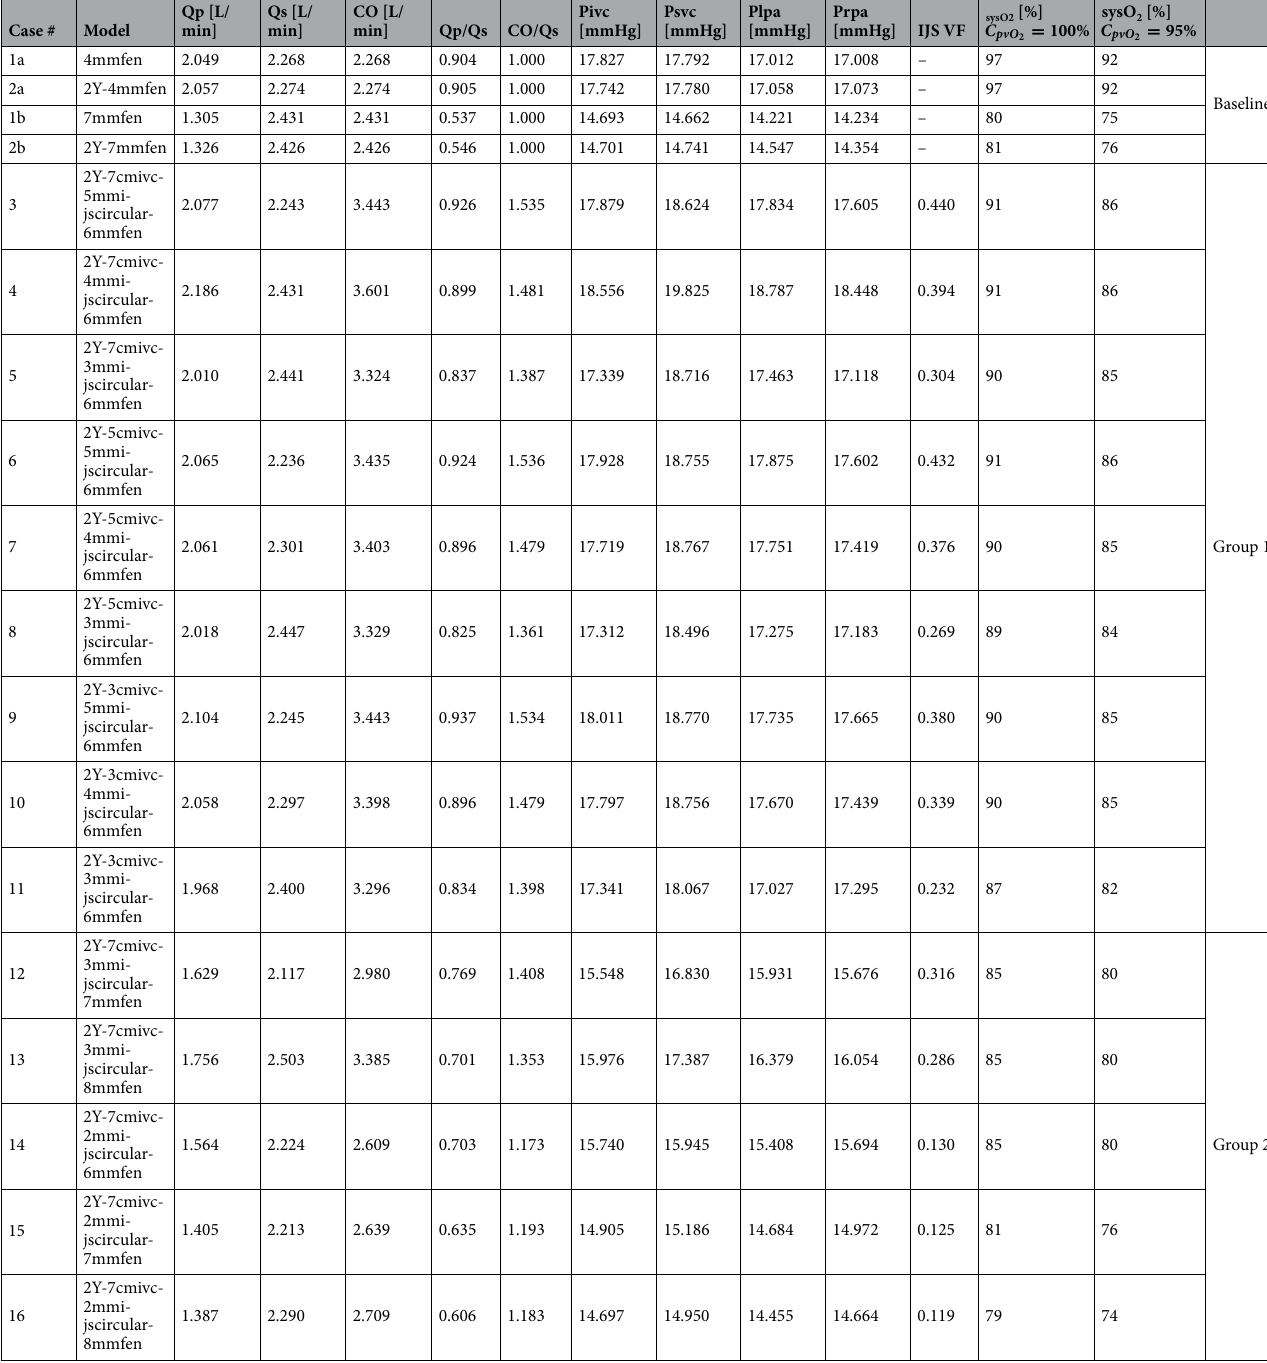
Table 2. Summary table of exploration of IJS and fenestration size and placement, including modified double Y-graft (2Y) anatomic variant (model nomenclature: [anatomic variant] − [distance from IJS nozzle to cavopulmonary connection] − [IJS diameter] − [fenestration